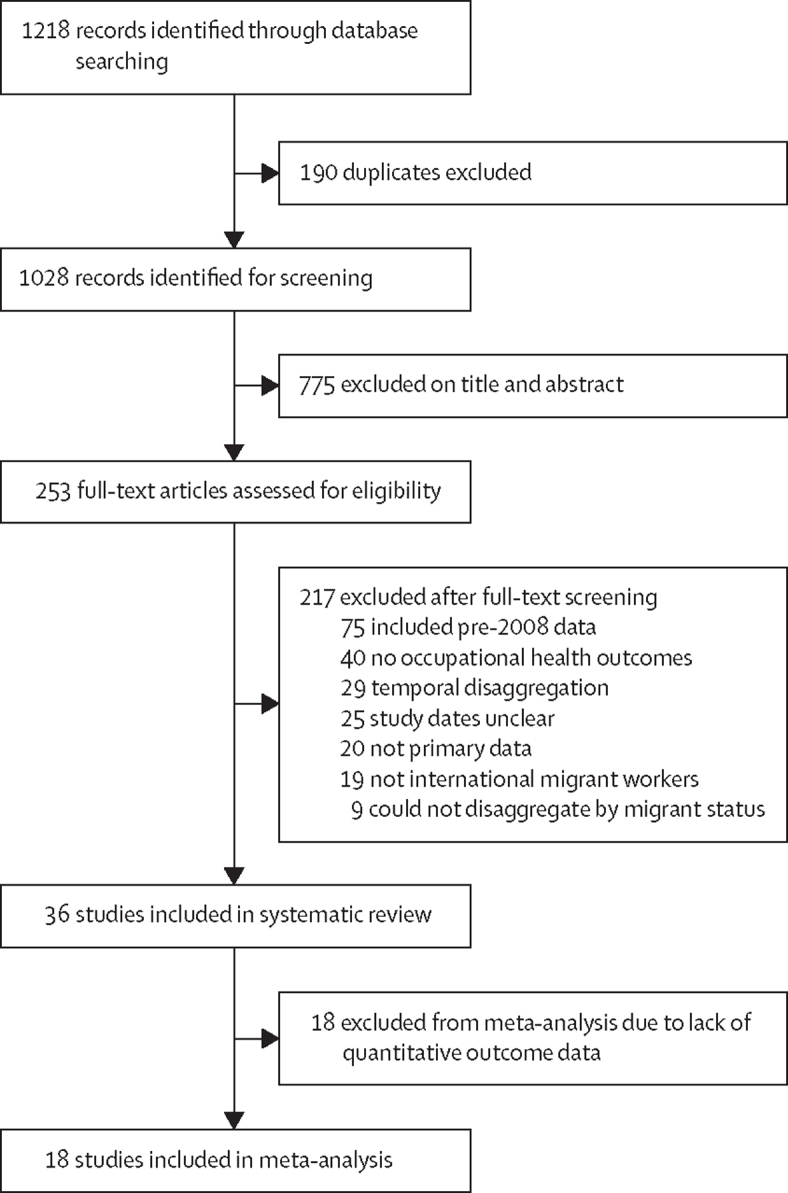
Study selection